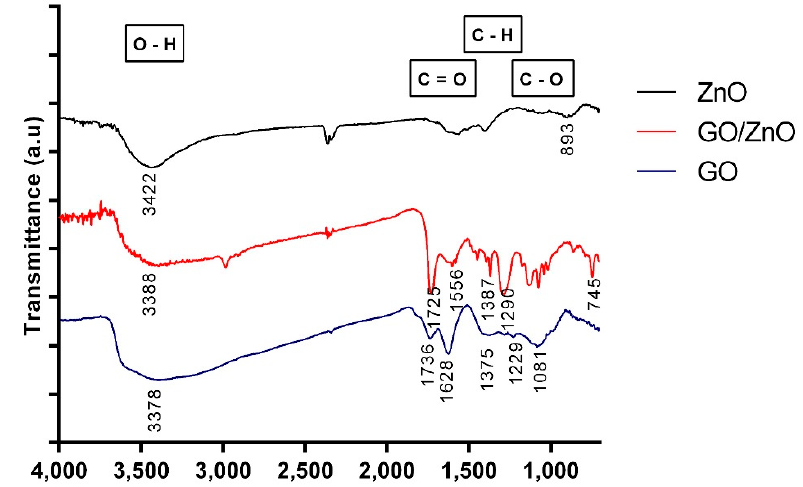
Figure 1. FT-IR spectrum of GO, ZnO and GO/ZnO nanoparticles.